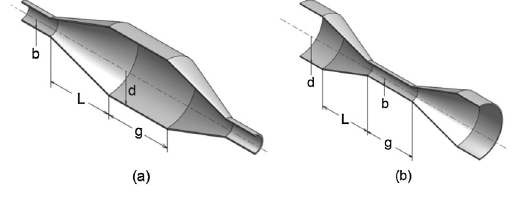
2. (a) Tapered cavity. (b) Tapered